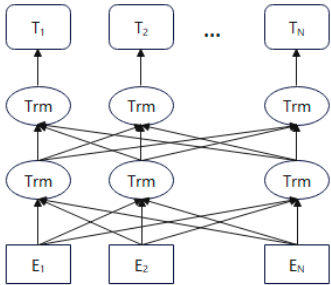
Figure 1. Structure of BERT model. Where E 1 , E 2 , …, E N represents the pre-processed text input, T 1 , T 2 ,…, T N represents the vector output trained by the BERT model. The Trm module is an Encoder structure from Transformer.